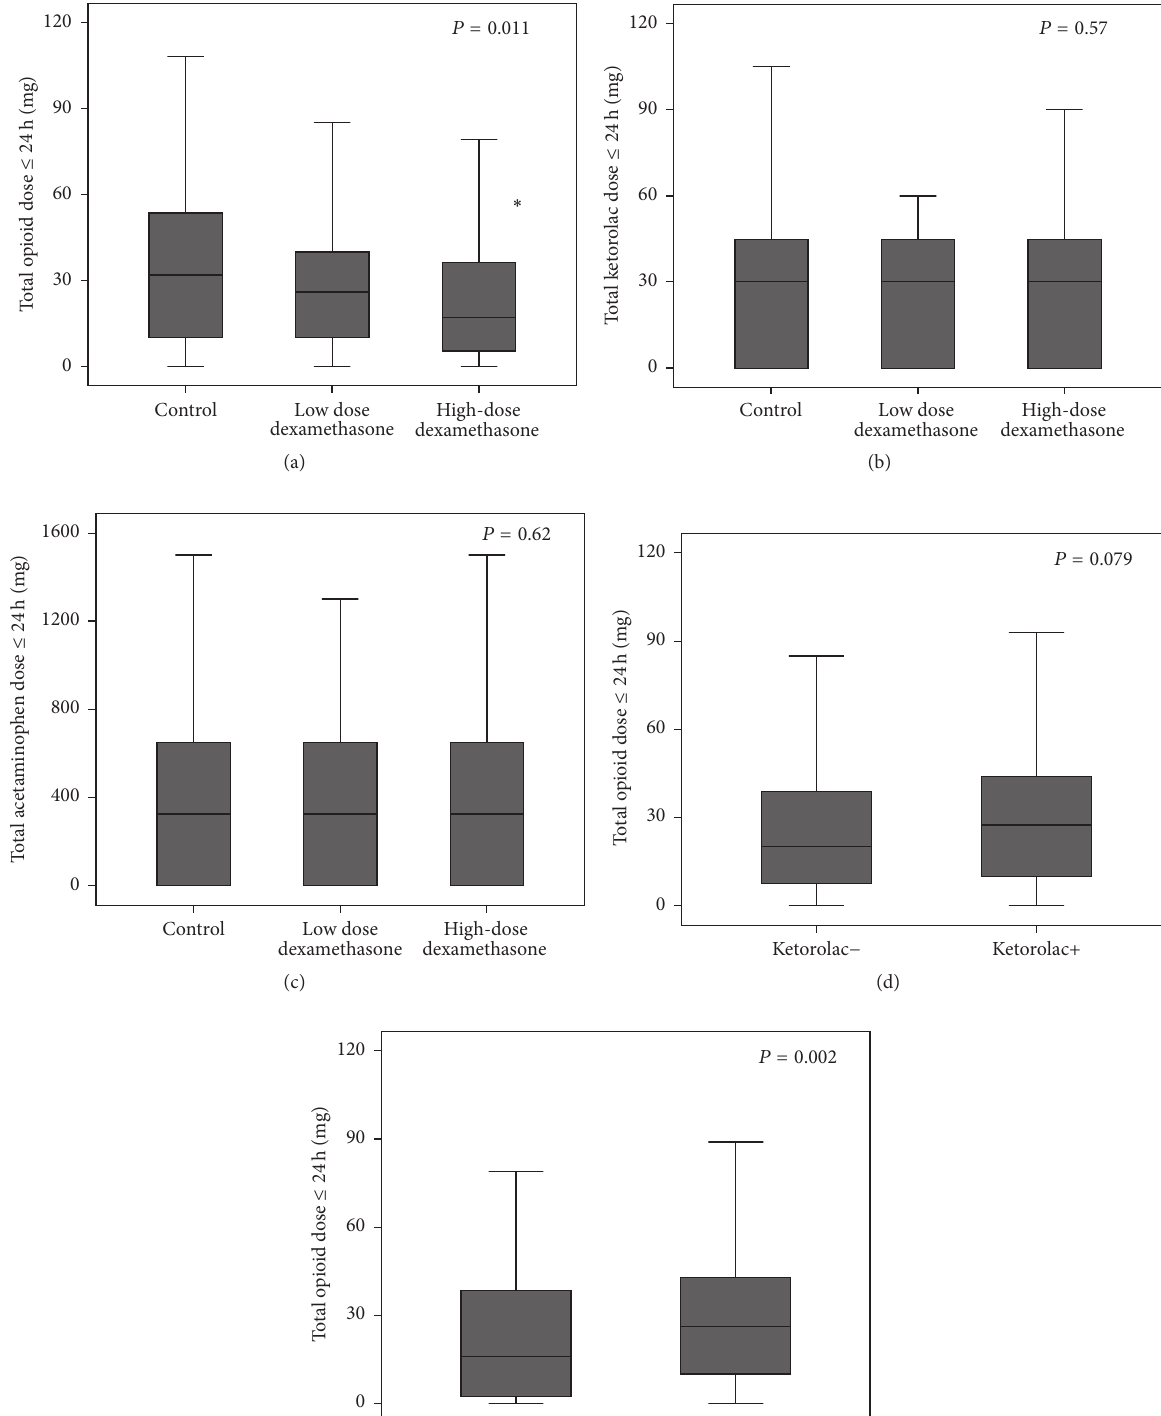
Figure 3: Box-and-whisker plot graphs showing total postoperative dose ( ≤ 24 h) of opioids (a), ketorolac (b), and acetaminophen (c) and subgroup analyses of opioid consumption with or without ketorolac ≤ 24h (d) and with or without acetaminophen ≤ 24 h (e). Error bars indicate the highest and lowest occurring value within a 1.5 interquartile range. ∗ Post hoc analysis control versus high dose 𝑃 = 0.008